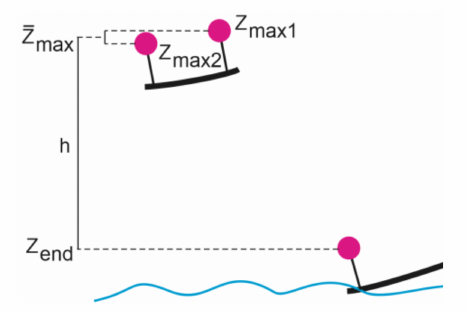
Figure 6. Illustration of jump height calculation from videogrammetrically determined 3D